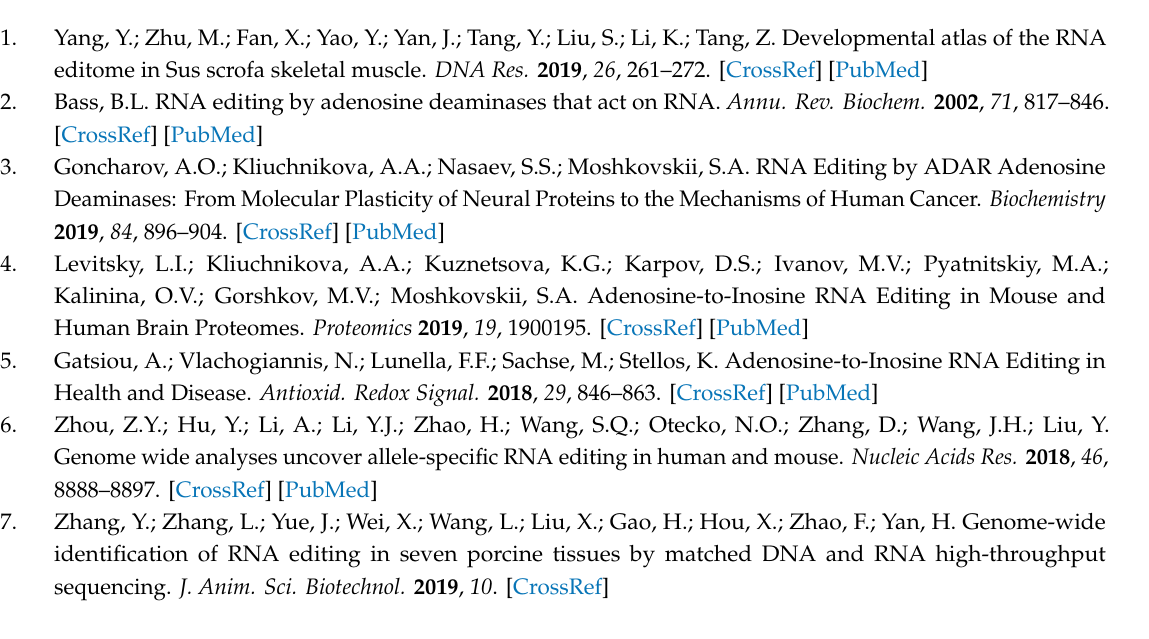
Table S1: Primer and the sequence information of editing sites for validation, Table S2: Blast results of retrieved sequence containing RNA editing sites, Table S3: Cluster of GO containing genes with di ff erential RNA editing sites in di ff erent group, Table S4: Alternative splicing type of genes with intronic RNA editing sites. Author Contributions: Conceptualization, L.W. (Ligang Wang) and L.W. (Lixian Wang); Formal analysis, L.W. (Ligang Wang), J.L., and L.W. (Lixian Wang); Investigation, X.L., J.L., X.H., H.G. and H.Y.; Methodology, X.L., J.L., F.Z. and L.W. (Ligang Wang); Resources: L.Z.; Supervision: H.Y., and L.W. (Lixian Wang); Writing—original draft: L.W. (Ligang Wang); Writing—review & editing: L.W. (Ligang Wang) and L.W. (Lixian Wang). All authors have read and agreed to the published version of the